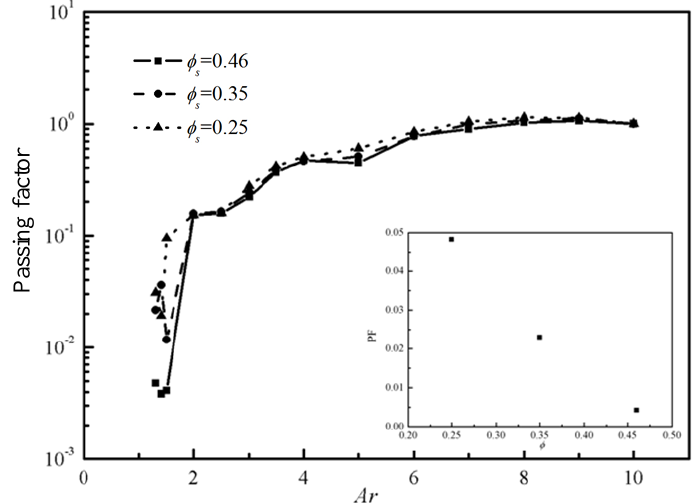
Figure 11. The passing factor PF with different ϕ s ( Gn = 266).